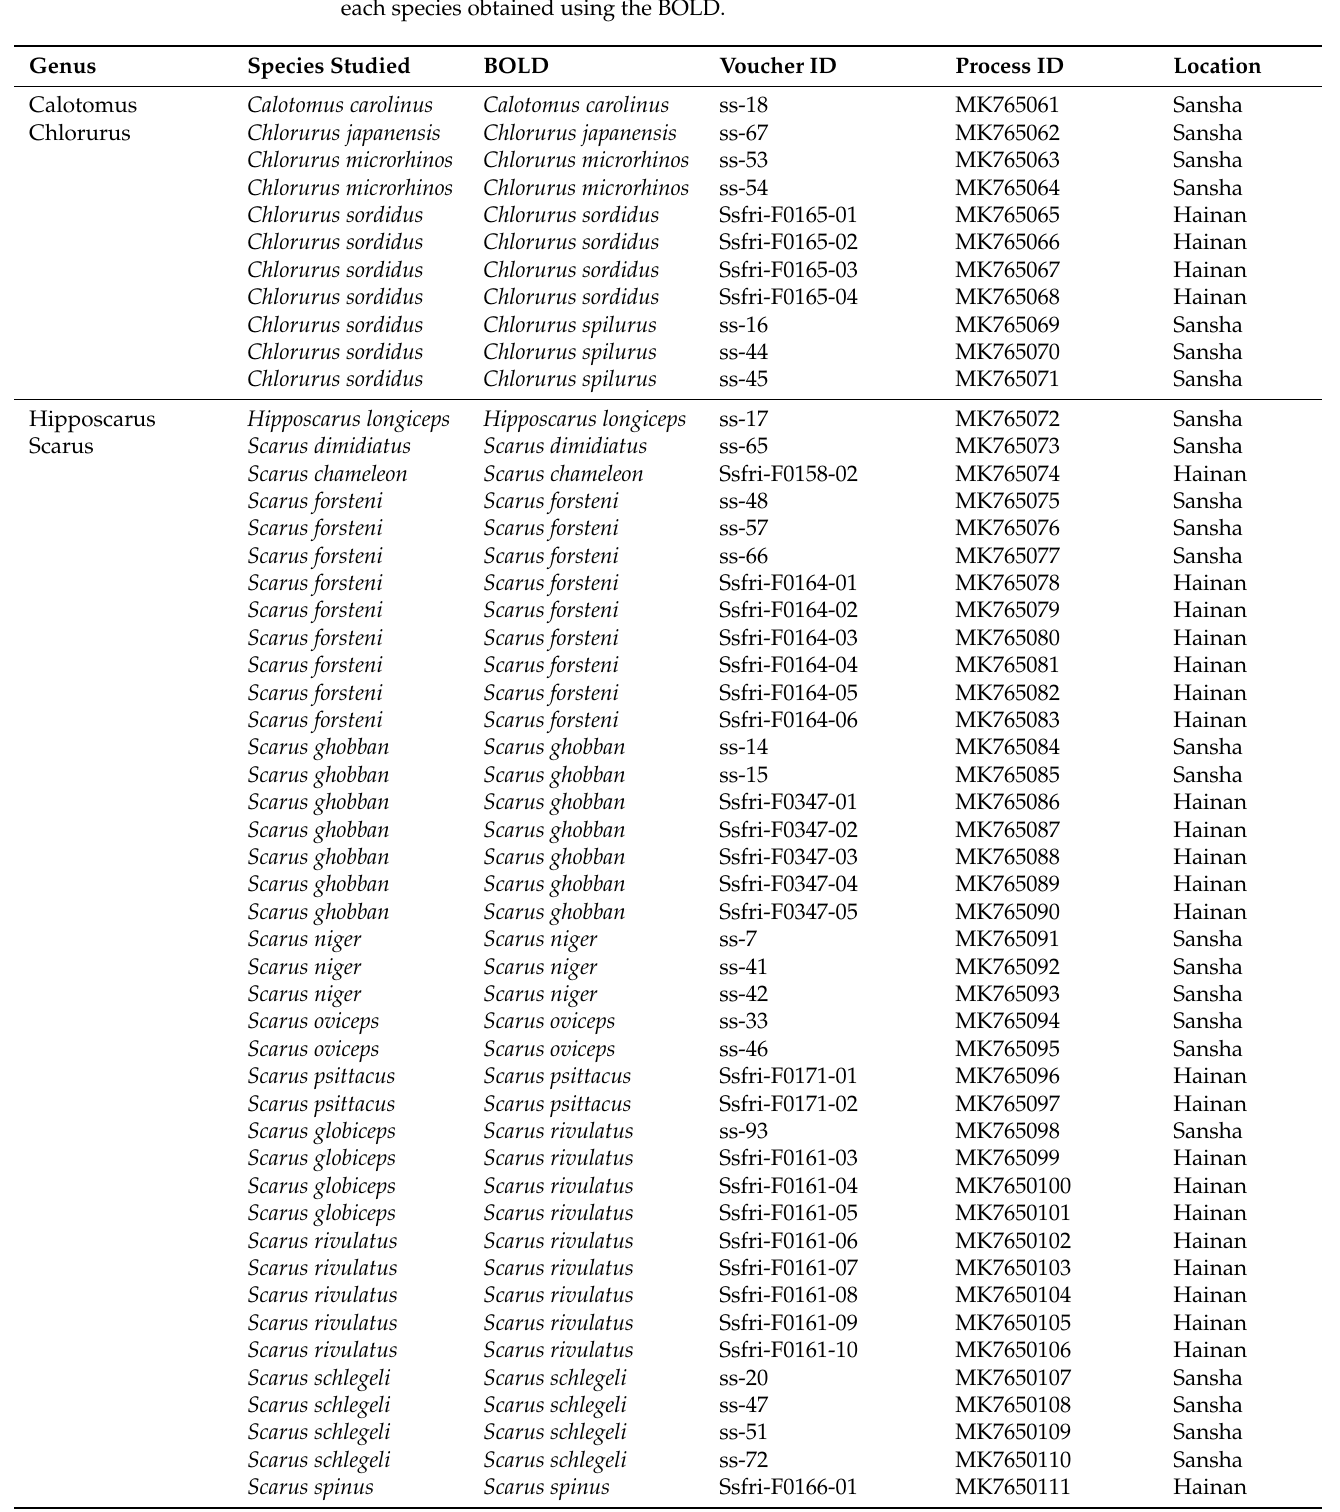
Table 1. Voucher and sequence information for the 51 specimens. Process IDs are sequence numbers of voucher specimens in GenBank, and Voucher IDs are voucher numbers in the South China Sea Fisheries Research Institute. BOLD is a summary of identification based on the barcode sequence of each species obtained using the